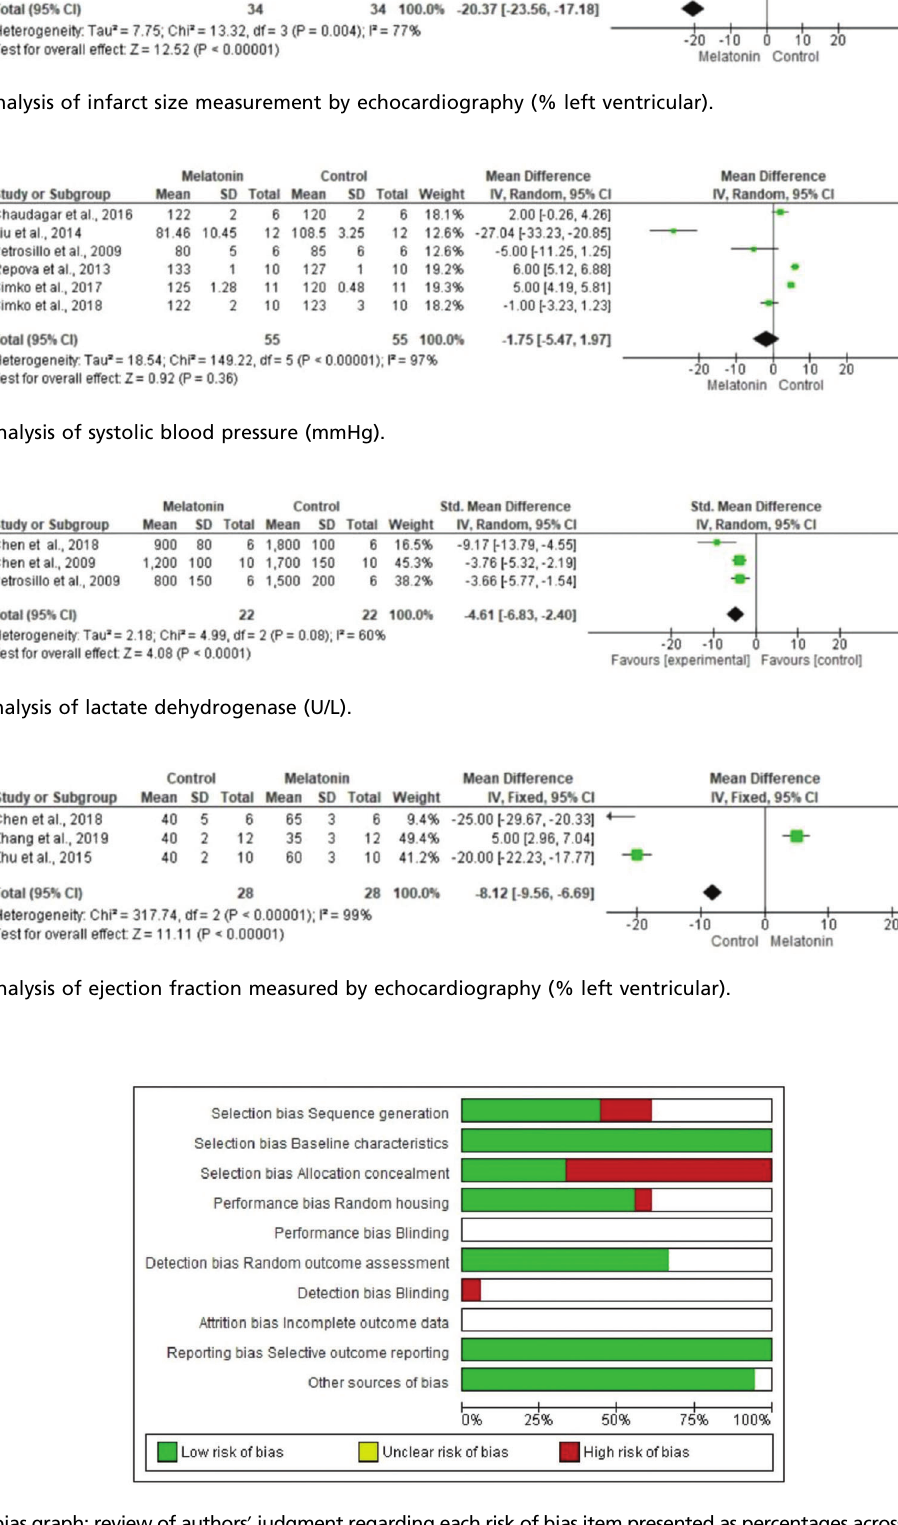
Figure 4 - Risk of bias graph: review of authors ’ judgment regarding each risk of bias item presented as percentages across all included studies.